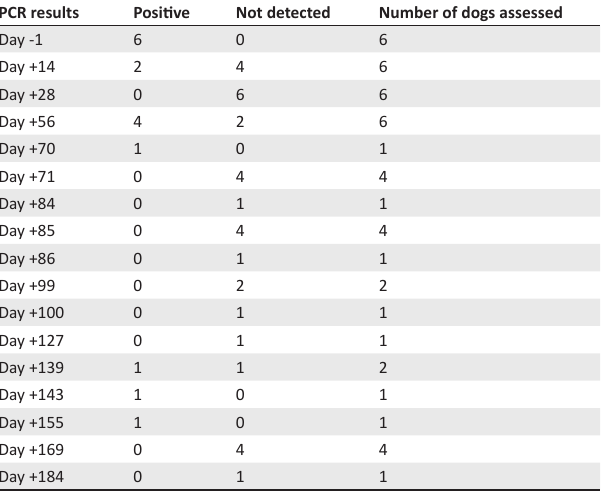
TABLE 4: Number of animals for which the polymerase chain reaction results on the respective study days (Days) indicated presence of Ehrlichia canis DNA. PCR results